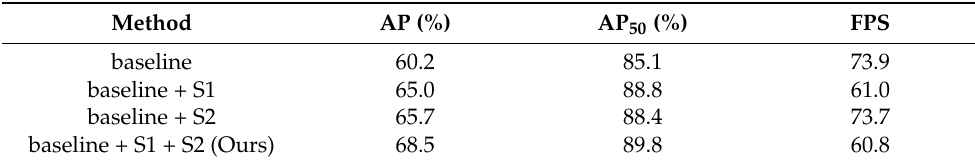
Table 1. The detection results of ablation